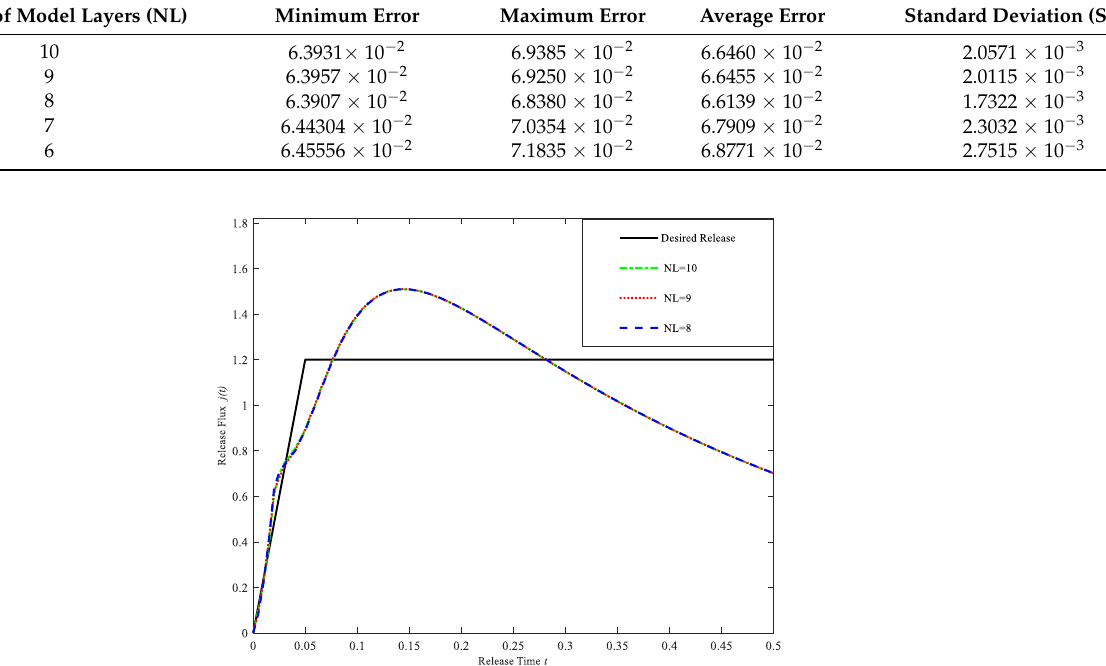
Table 5. Statistical analysis of the error for optimization of the initial drug concentration (Case 3).